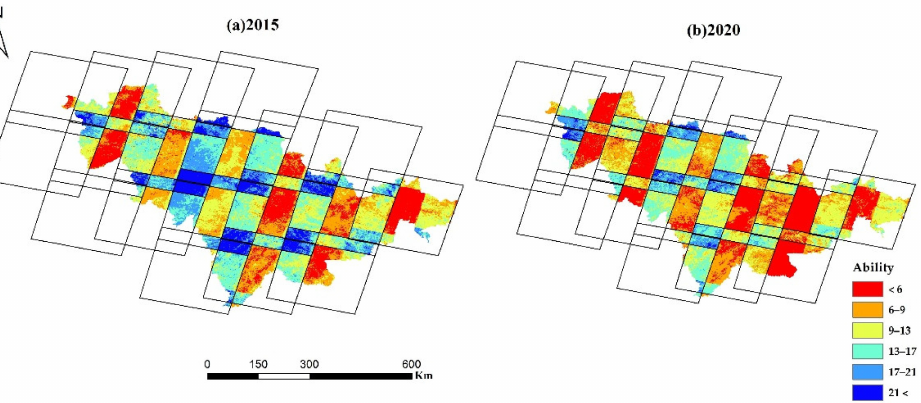
Figure 10. Available quantity of Landsat images. ( a ): Available quantity of Landsat images in 2015; ( b ): Available quantity of Landsat images in